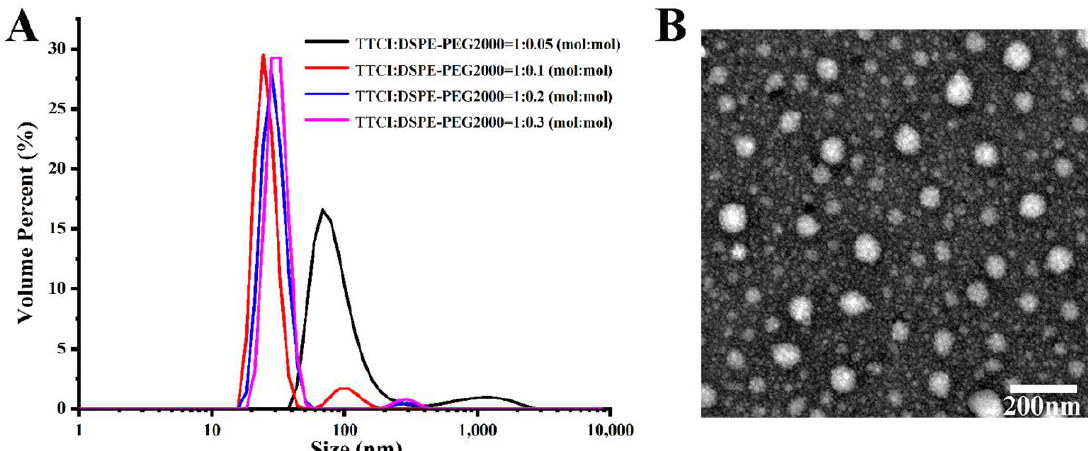
Figure 1. ( A ) Size distribution of CPI-613-prodrug NPs constructed with different molar ratios of TTCI :DSPE-PEG2000. ( B ) The TEM image of CPI-613-prodrug NPs constructed with TTCI :DSPE-PEG2000 at a molar ratio of 1:0.2. Scale bar = 200 nm.